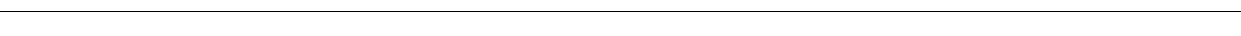
Figure 4 | Cripto controls the metabolic reprogramming in ESC - EpiSC transition. ( a ) Venn diagram of genes differentially expressed ( Z 2-fold) or uniquely deregulated in Cripto KO versus WT ESC - EpiSC transition. ( b ) GO analysis (http://david.abcc.ncifcrf.gov) of protein coding genes (979) uniquely deregulated in WT ESC - EpiSC showing gene enrichment in KEGG Pathway. ( c ) Heatmap of genes involved in oxidative phosphorylation in WT and Cripto KO ESC - EpiSC transition. ( d ) Lactate concentration of F/A WTand Cripto KO cells. Two independent Cripto KO ESCs (KO.1 and KO.2) were used. Data are mean ± s.e.m. ( n ¼ 3; * P o 0.01 and ** P o 0.005). ( e ) Schematic representation of the experimental procedure. ( f ) Representative immunofluorescence of Claudin6 and Otx2 in F/AWT, Cripto KO and Cripto KO þ oligomycin colonies and cytospinned cells (scale bar, 75 m m). Inserts are higher magnification images of selected areas. ( g ) Proliferation of F/A WT, Cripto KO and Cripto KO þ oligomycin cells measured by the CyQuant assay and expressed as relative fluorescence units (RFU). Data are mean ± s.e.m. ( n ¼ 3; * P o 0.01). ( h ) qPCR of selected markers in F/A WT, Cripto KO and Cripto KO þ oligomycin. Relative RNA level was normalized to Gapdh ; data are mean ± s.e.m. ( n ¼ 3; * P o 0.01). ( i ) Lactate concentration of F/A WT, Cripto KO and Cripto KO þ oligomycin cells. Data are mean ± s.e.m. ( n ¼ 3; ** P o 0.005). ( j ) Western blot analysis of Cripto and p-Smad2 in F/A WTand Cripto KO cells. Smad2 and Gapdh were loading controls. ( k ) qPCR of Pgc-1b . Data are fold induction of Cripto KO versus WT F/A after normalization to Gapdh and are mean ± s.e.m. ( n ¼ 3; * P o 0.01). ( l ) qPCR of Pgc-1b on F/AWTand Cripto KO cells transfected with two independent Pgc-1b small interfering RNAs (siRNAs) (KO/siPgcb) or control siRNA (KO/Scr.) at day 3 during ESC - EpiSC. Data are fold induction of Cripto KO versus WT and KO/Scr. versus KO/Pgcb after normalization to Gapdh and are mean ± s.e.m. ( n ¼ 3; * P o 0.01). ( m ) Western blot analysis of Pgc-1b in F/A WT, Cripto KO, Cripto KO/Scr. and Cripto KO/siPgc-1b (KO/Pgcb). Gapdh were loading controls. The densitometric analysis is expressed in arbitrary unit (ADU) as the Pgc-1b/Gadph ratio. Data are mean ± s.e.m. ( n ¼ 2). ( n ) qPCR of Cox7a1 and ( o ) lactate concentration in culture medium of F/A WT, Cripto KO/Scr and Cripto KO/Pgcb. Relative RNA level was normalized to Gapdh. Data are mean ± s.e.m. ( n ¼ 3; * P o 0.01). NATURE COMMUNICATIONS|7:12589|DOI: